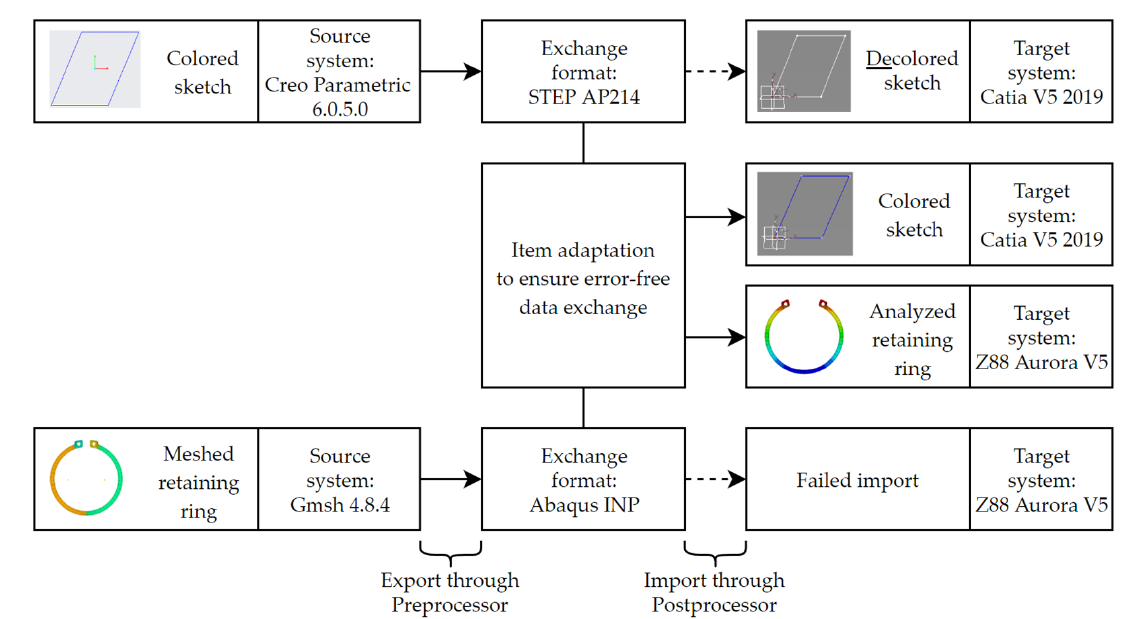
Figure 15. Compatibility Improvement of partial models of a sketch and a retaining ring using item adaptation.